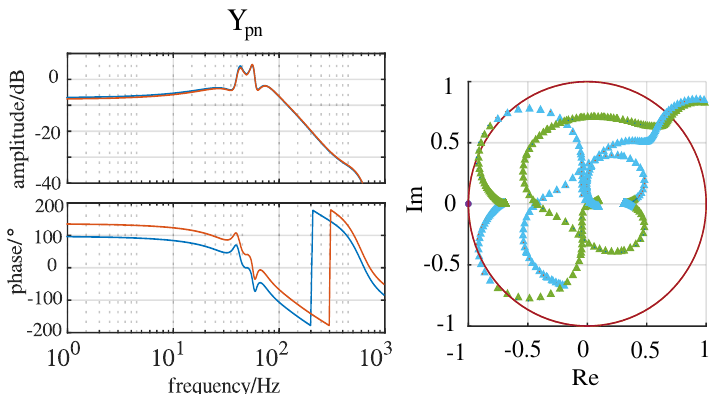
Figure 10. Eigenloci of interconnected system where the error indicator J 1 = 0.10633. ( a ) Bode diagram of off-diagonal element Y pn . Line: local-reference-frame-based impedance model; Dashed-dotted line: global-reference-frame-based impedance model. ( b ) Eigenloci of interconnected system. Line with triangles: eigenloci calculated according to local reference frame; Line with circles: eigenloci calculated according to global reference